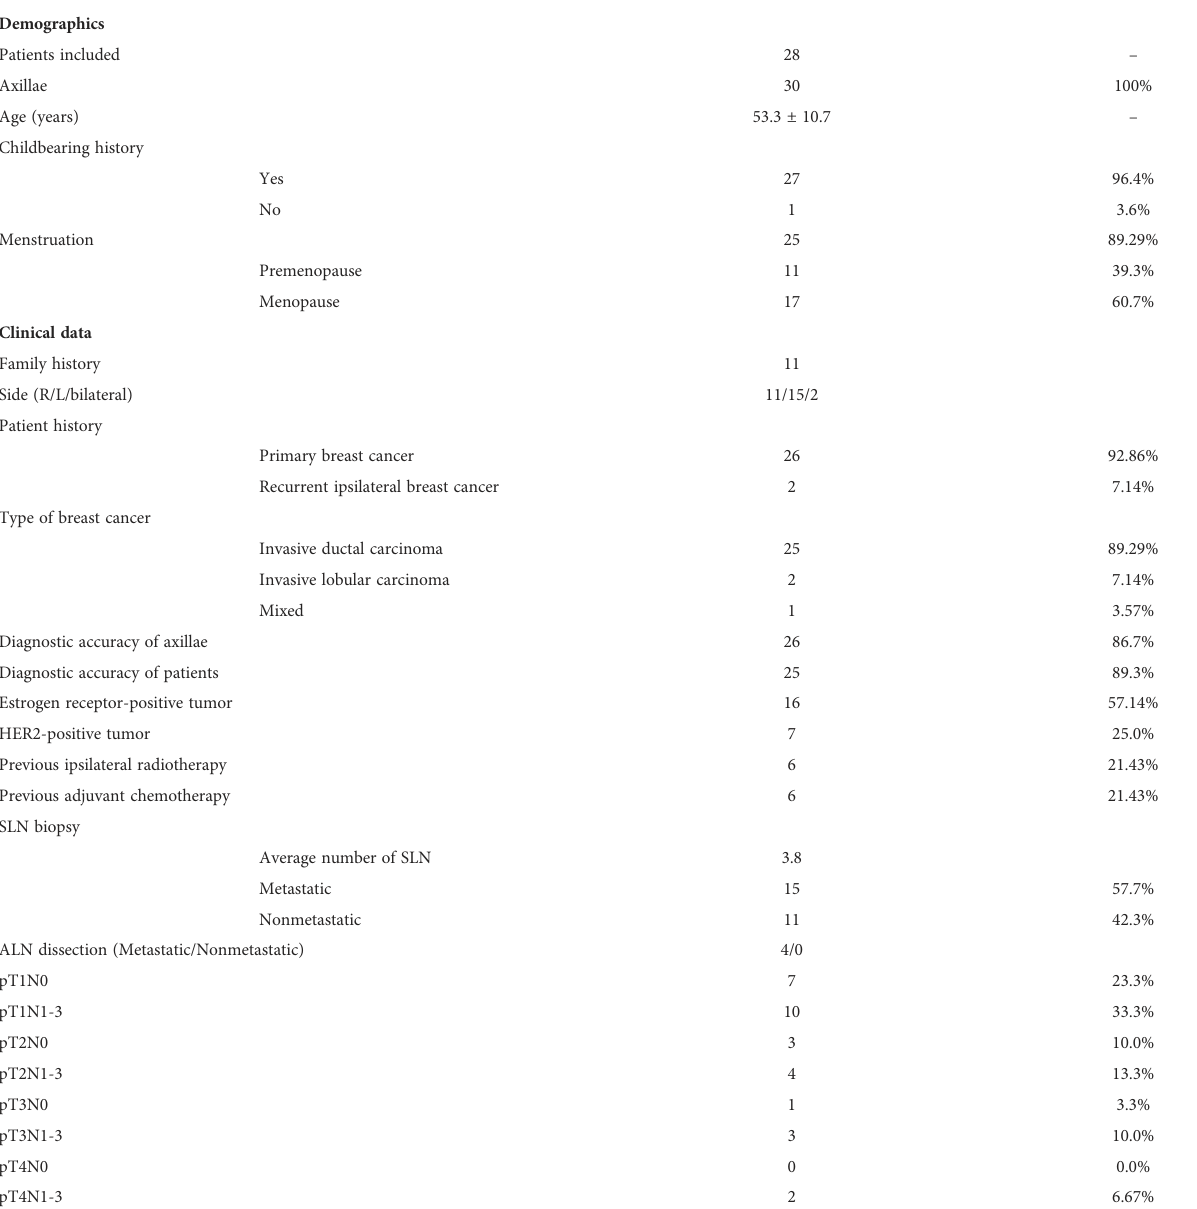
TABLE 1 Patient demographics and clinical